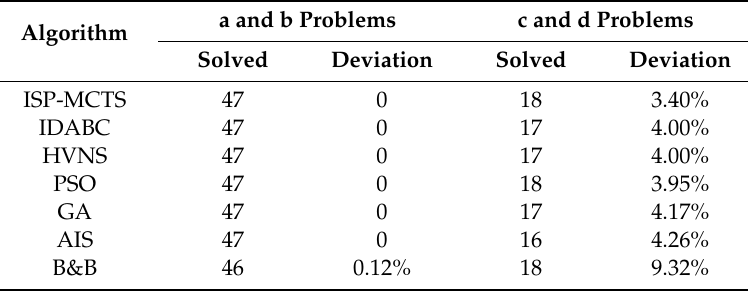
Table 6. Performance summary of the di ff erent